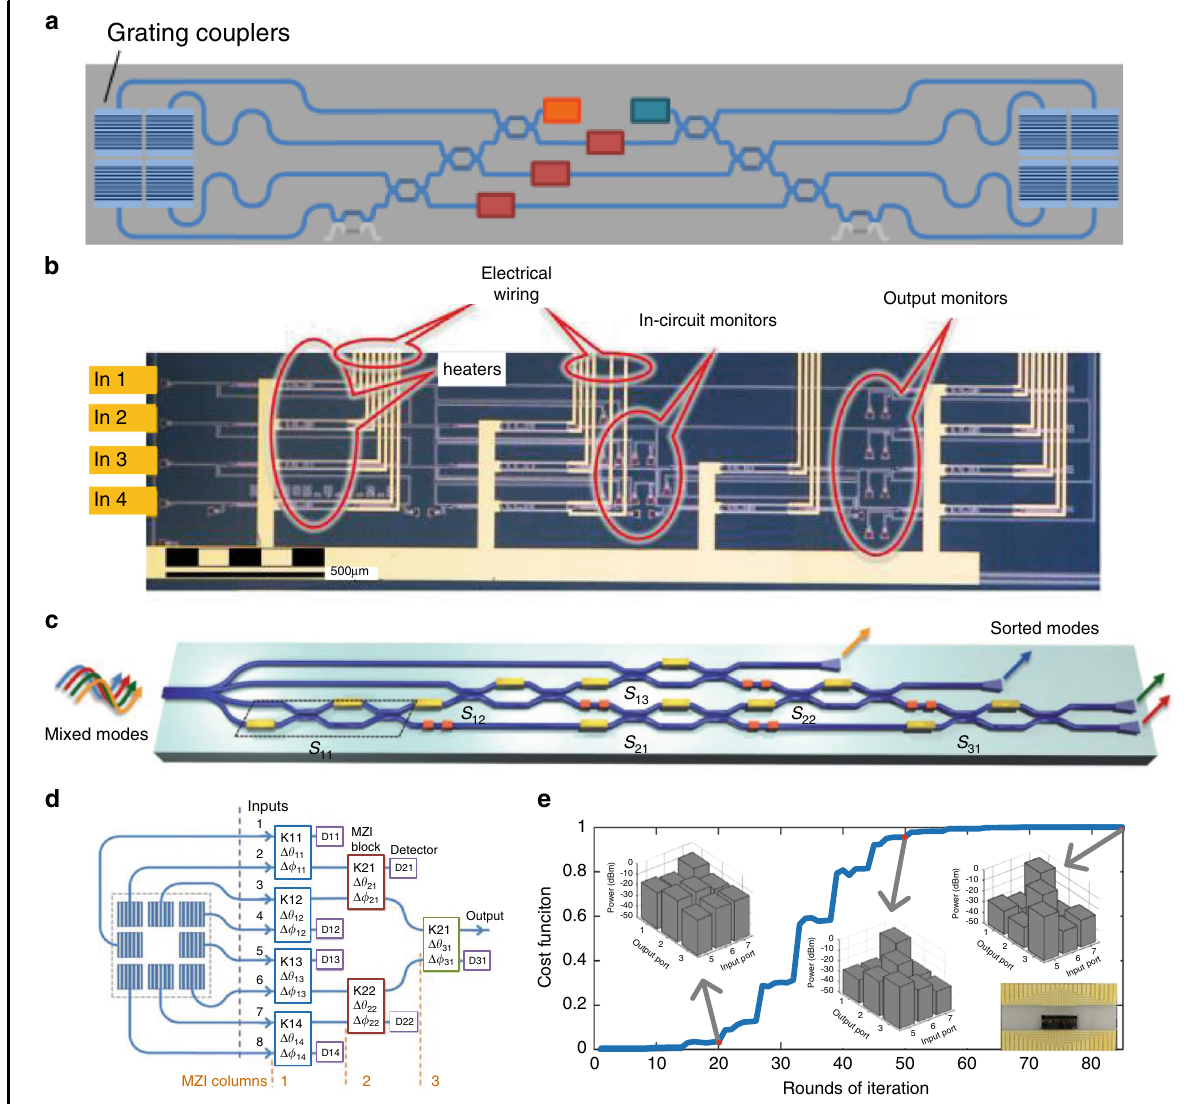
Fig. 6 MZI-MVMs for optical signal processing. a Add-drop mode multiplexer 66 . b 4 × 4-port universal linear circuit 68 . c Optical mode descrambler 69 . d Analysis and generation of multimode optical fi elds 76 . e Self-con fi gured example 103 . a Reprinted with permission from ref. 66 ©